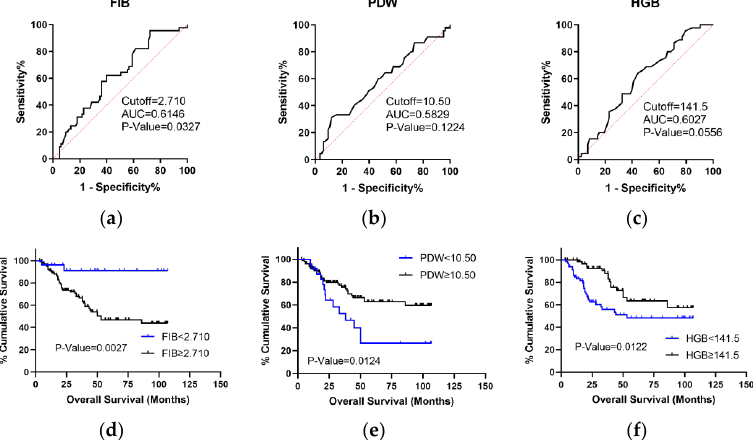
Figure 4. ROC and Kaplan – Meier (K-M) analyses of peripheral blood parameters to predict overall survival (OS) in LSCC. ( a – c ) ROC analysis of peripheral blood parameters to predict OS (AUC > 0.58). ( d – f ) K-M analysis of peripheral blood parameters for OS with the log-rank test ( p < 0.05).